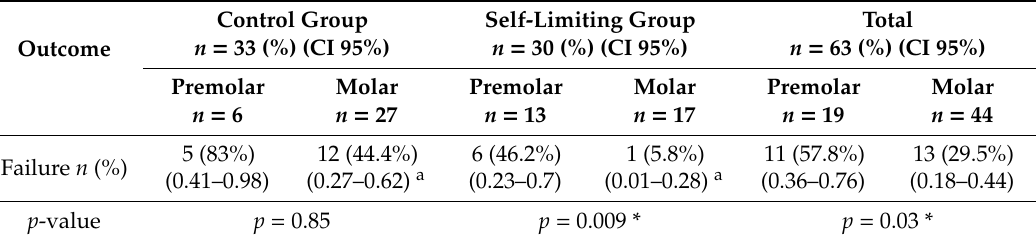
Table 4. Distribution of failed teeth according to tooth type at